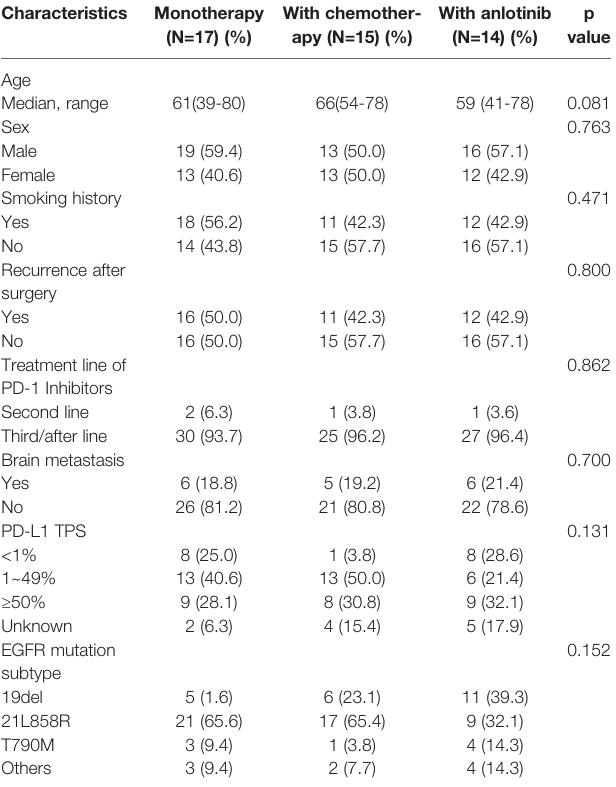
TABLE 4 | Clinicopathological characteristics of all patients with different treatments. Characteristics